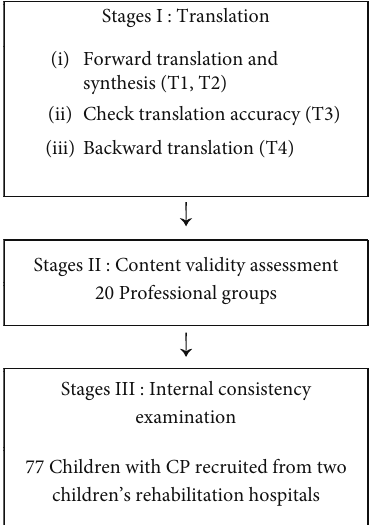
Figure 1: Flowchart of the study